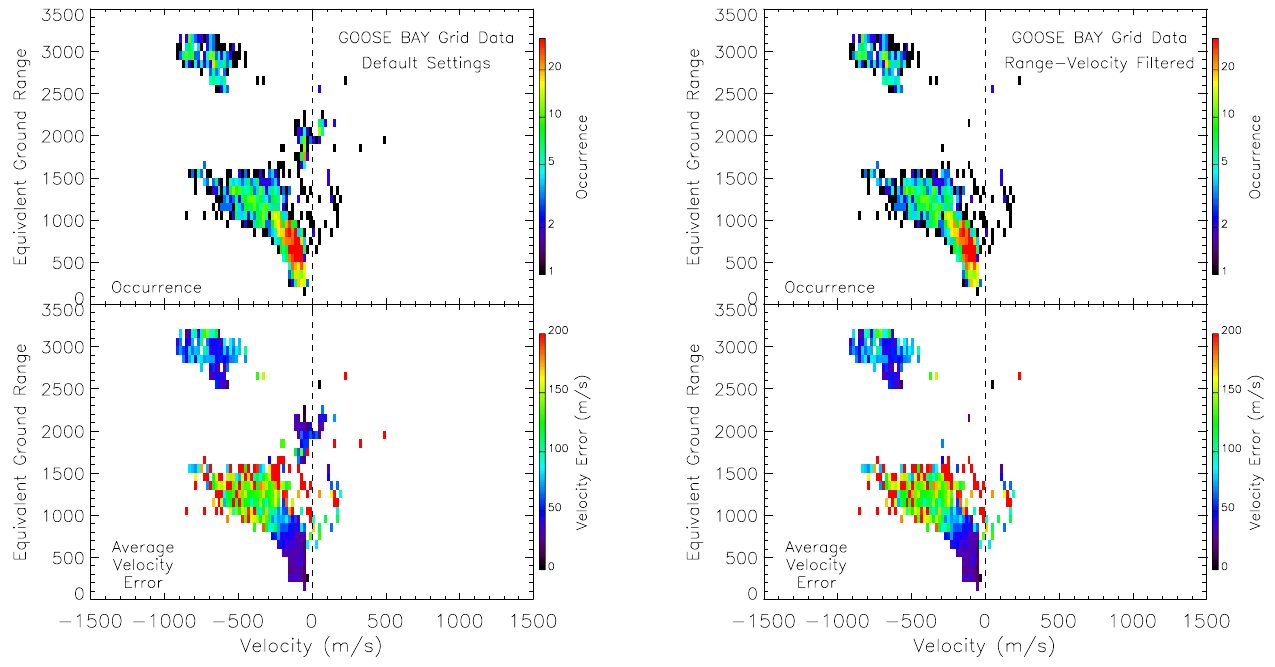
Fig. 7. Gridded velocity distribution from the Goose Bay radar for the interval 13:00–14:16 UT on 11 February 1998, using (a) the default processing, and (b) velocity-range gate filtering. Also shown is the average velocity error measured in each distribution